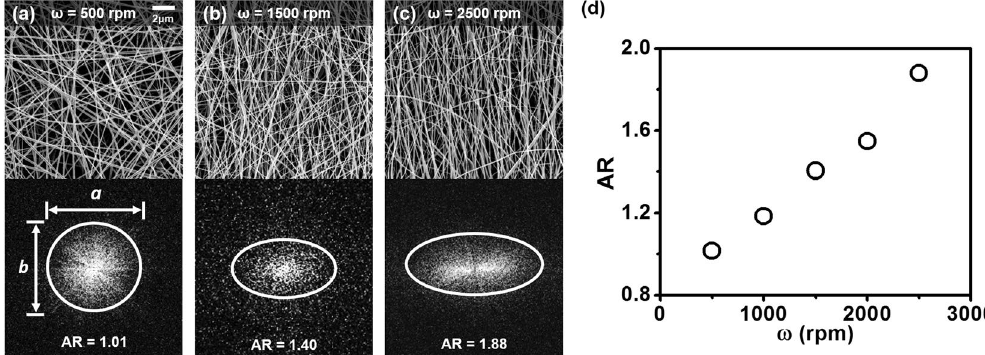
Figure 1. ( a – c ) (Top) Representative SEM images of electrospun SF nanofibers assembled at collection drum speeds of ( a ) 500 rpm, ( b ) 1,500 rpm, and ( c ) 2,500 rpm. (Bottom) Amplitudes of the 2D Fourier transforms of ( a ), ( b ), and ( c ). Here, ( a and b ) denote the FWHMs of the averaged profiles along the x and y directions, respectively. ( d ) Aspect ratios (ARs) evaluated as a/b for the scaffolds fabricated with different speeds of collection